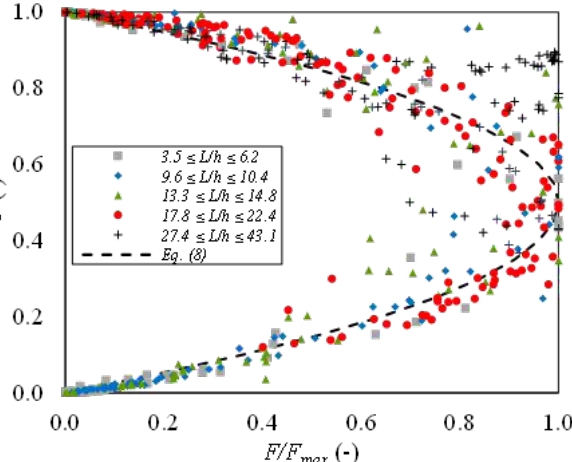
Figure 10. Dimensionless air–water phase-change count rate F/F max as a function of the void fraction distribution C .